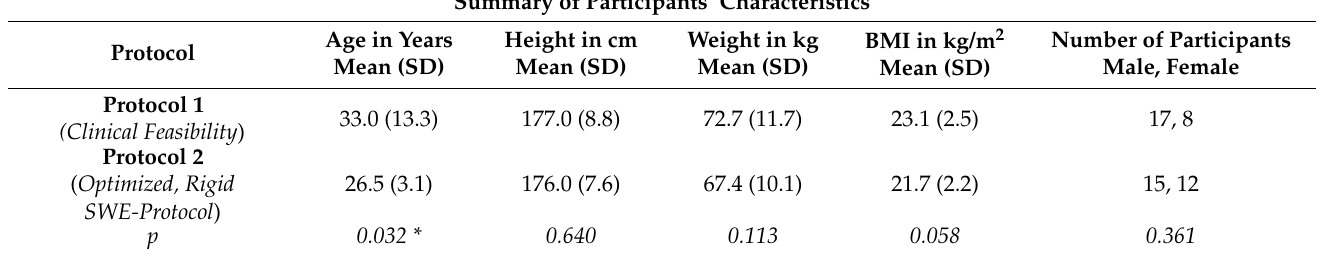
Table 1. Summary of participants’ characteristics examined in this study. The two groups did not differ significantly in terms of height, weight or BMI.